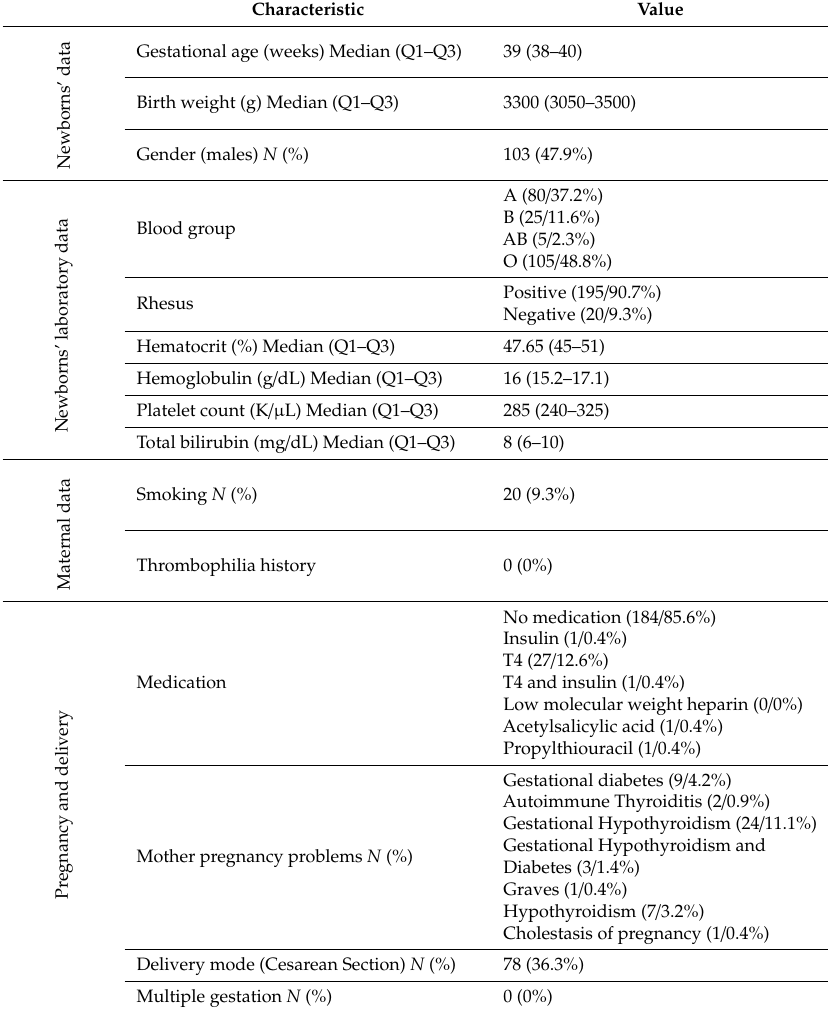
Table 1. Baseline characteristics of the study population.